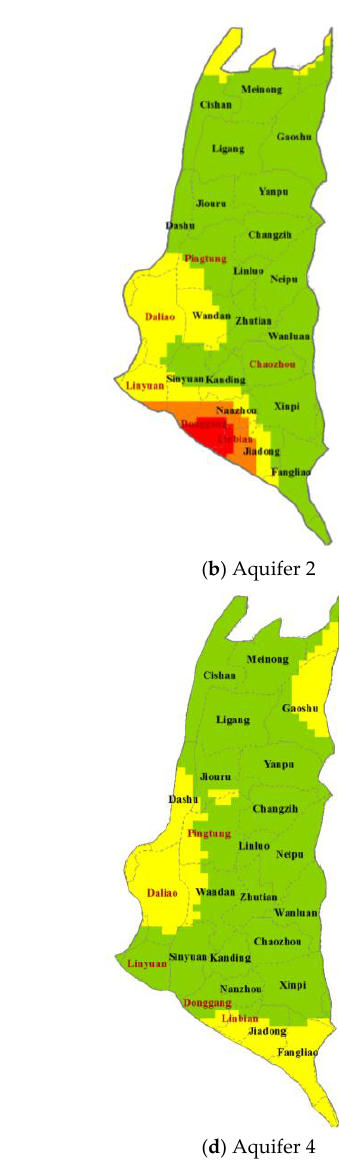
Figure 5. Spatial distribution of arsenic concentrations mapped using the geostatistical method.